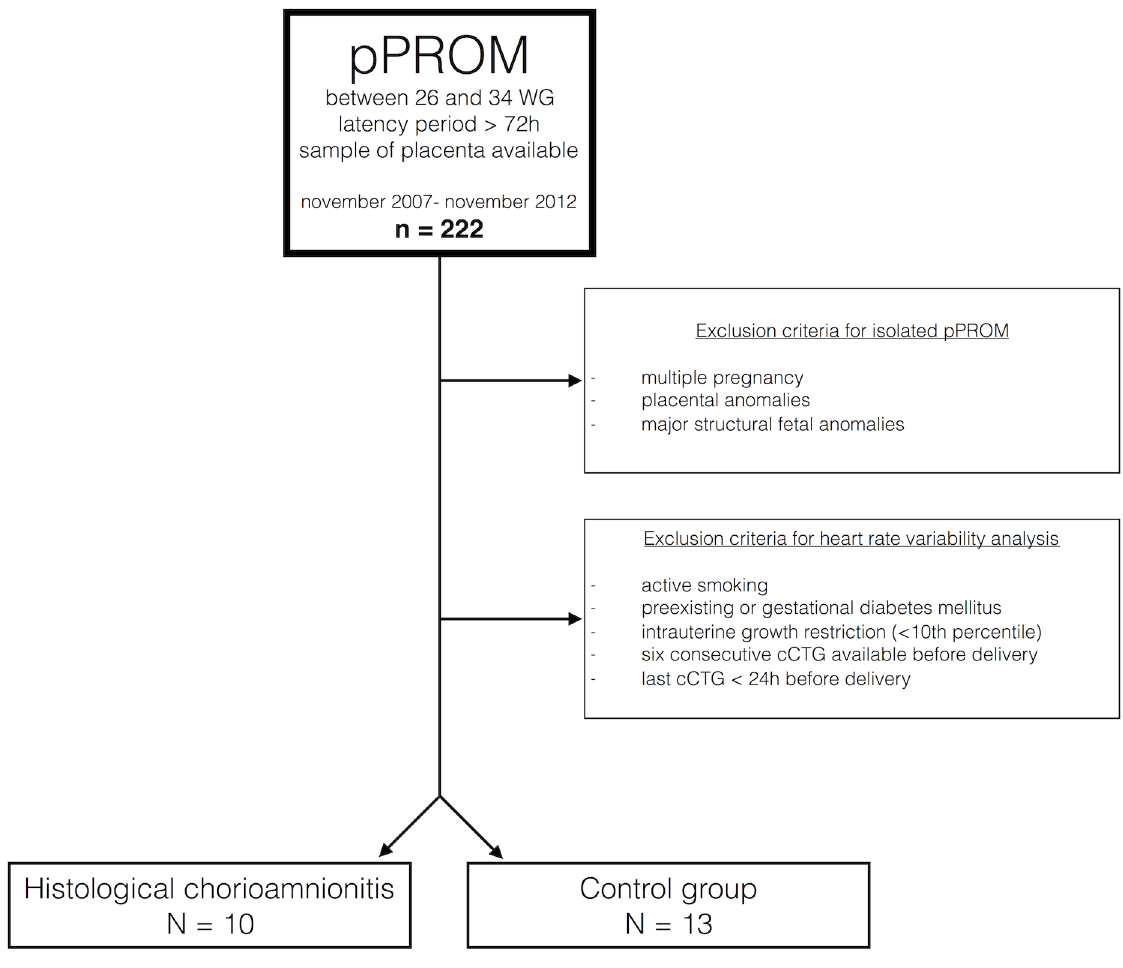
Fig 1. Flowchart of the study.